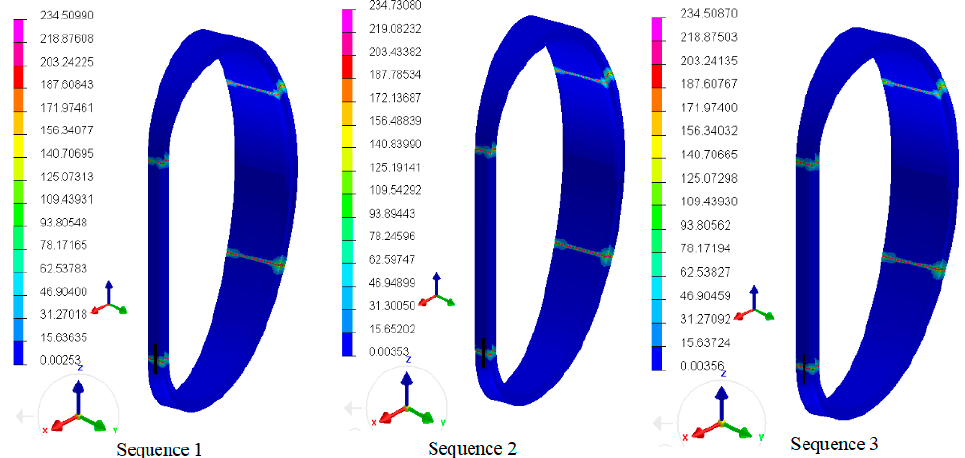
Figure 18. Colored maps of welding stresses in the three different sequences. The values on the left represent von Mises effective stress, different colors represent different stress values, and specific routes (black lines) were chosen at the same position in three sequences to analyze the effect of welding sequences on the welding stress concretely.